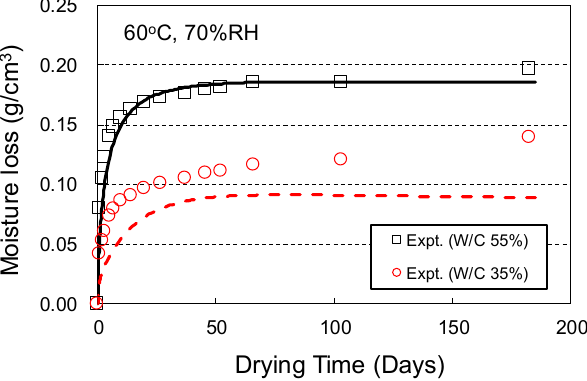
Figure 17. Comparison of weight loss based on the modified model (W/C = 35%, 55%) [28].